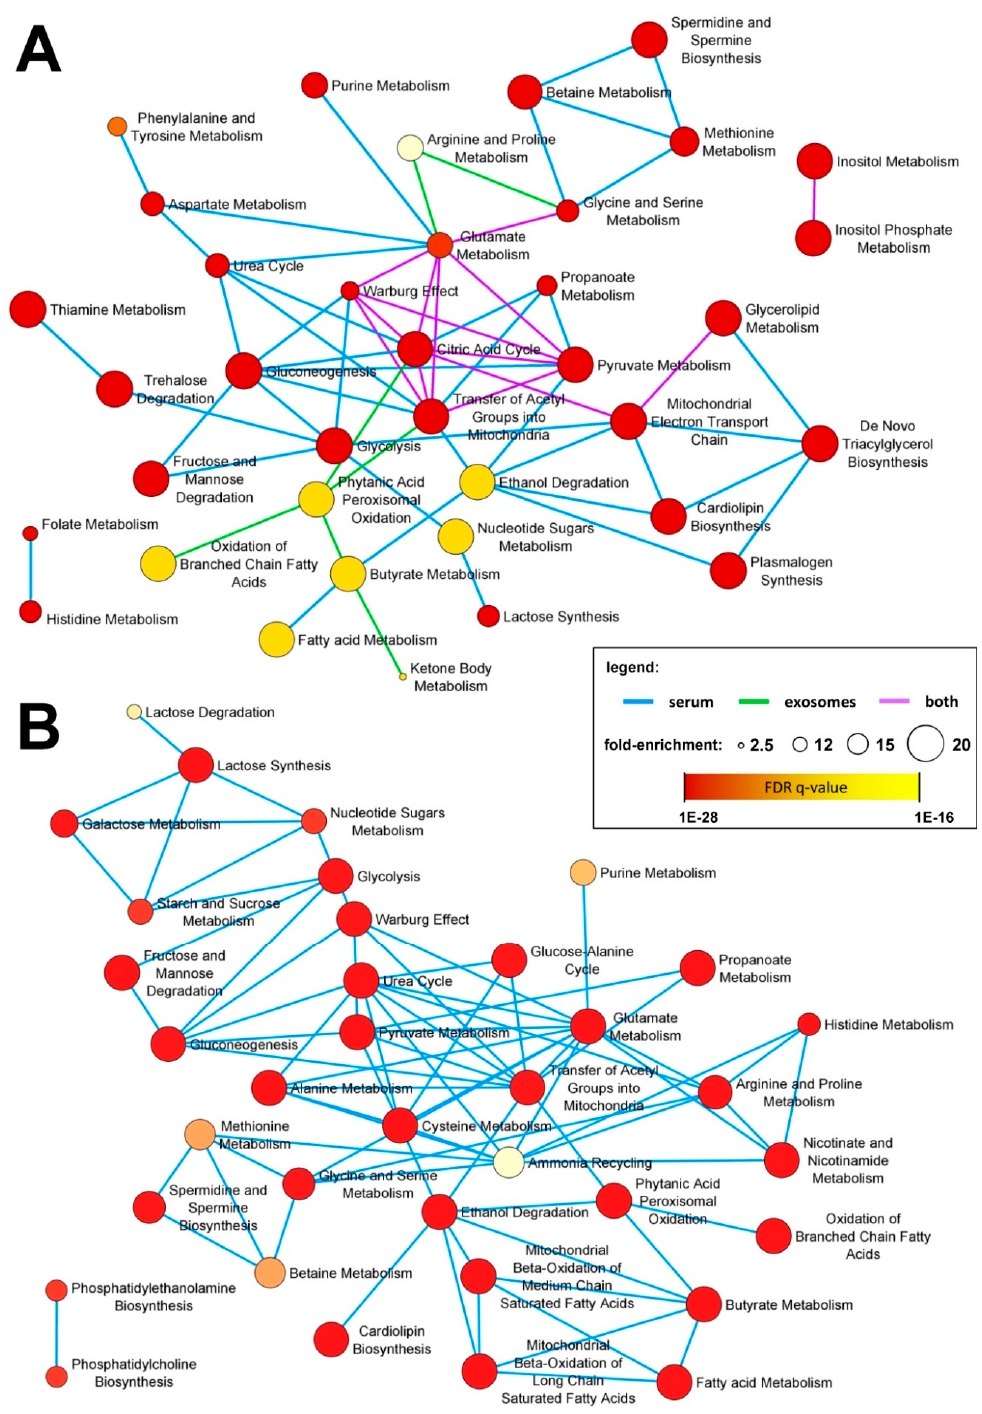
Figure 5. Metabolic pathways associated with specific subsets of compounds detected in the whole serum and serum-derived exosomes. Illustrated are over represented pathways associated with metabolites di ff erentiating between cancer and control samples (panel A ) and between pre-RT and post-RT samples (panel B ); metabolites that showed large and medium e ff ect size were included. The size of the network nodes corresponds to the pathway’s fold-enrichment while the statistical significance of the over-representation is color